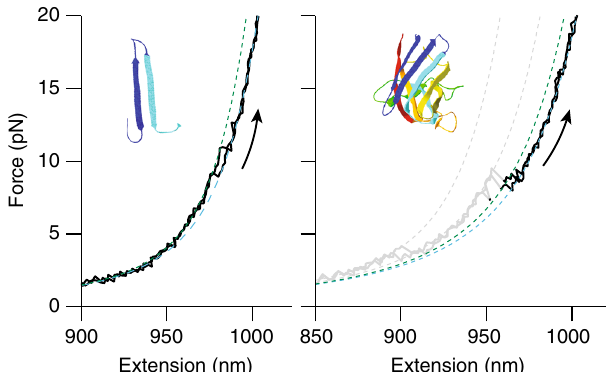
Fig. 4 FECs of β 2 – 3 hairpin peptide. A peptide containing the residues in strands 2 and 3 folds into a stable structure whose unfolding (left) is similar to that of intermediate I 1 in SOD1 (right), consistent with the proposed structure for I 1 in Fig. 3b. Dashed lines: WLC fi ts to the I 1 intermediate (green), other intermediate (gray), and unfolded (cyan) states. Average contour length change for unfolding the hairpin peptide: 8.3 ± 0.8 nm (246 FECs from four molecules), compared to 7.7 ± 0.3 nm for unfolding I 1 (1346 FECs from 11